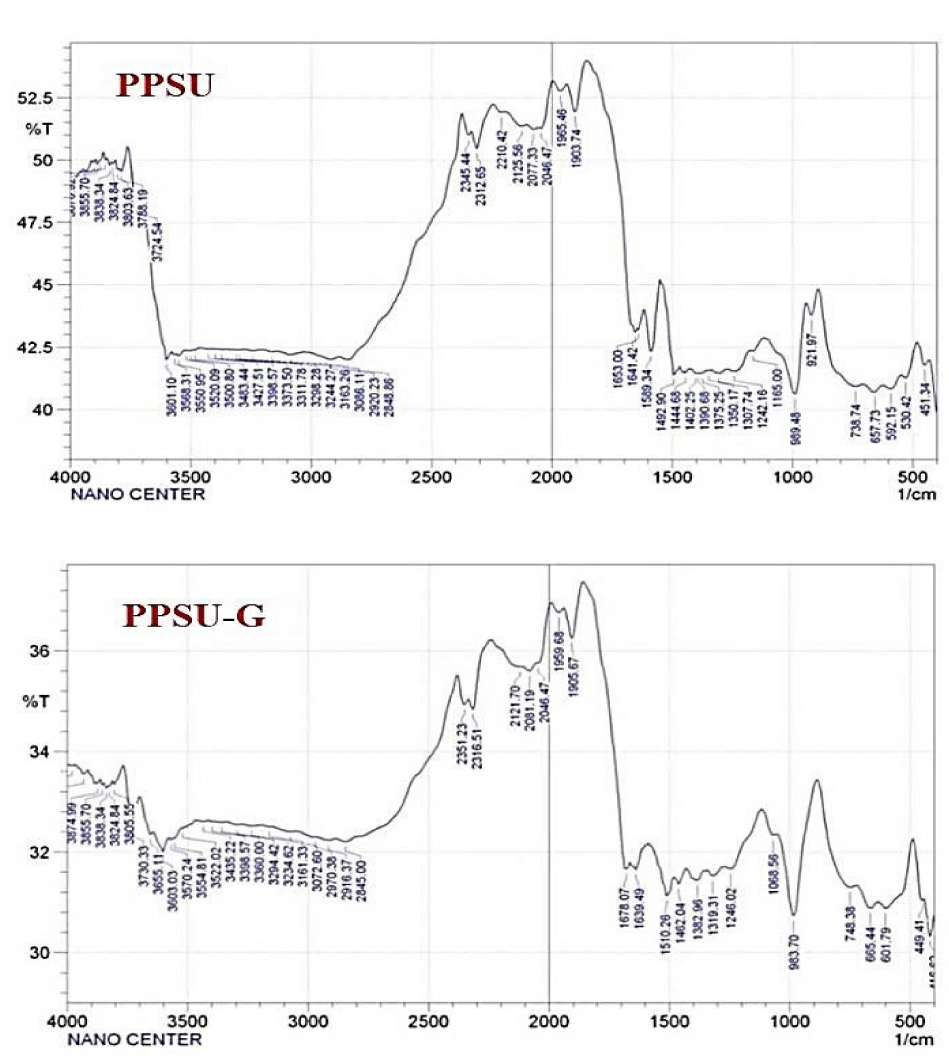
Figure 5. FTIR spectra of synthesized pristine PPSU and PPSU-GGA